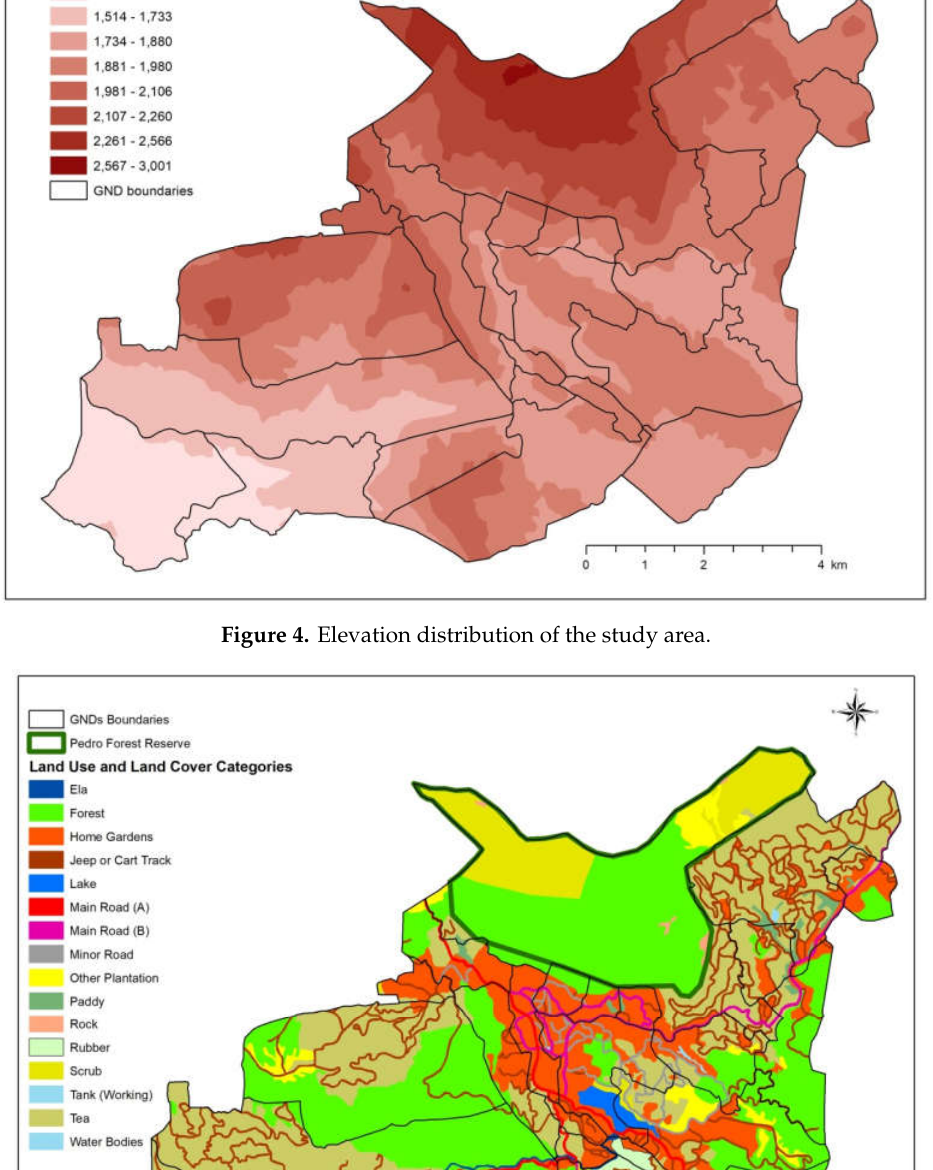
Figure 3. Slope distribution of the study area.